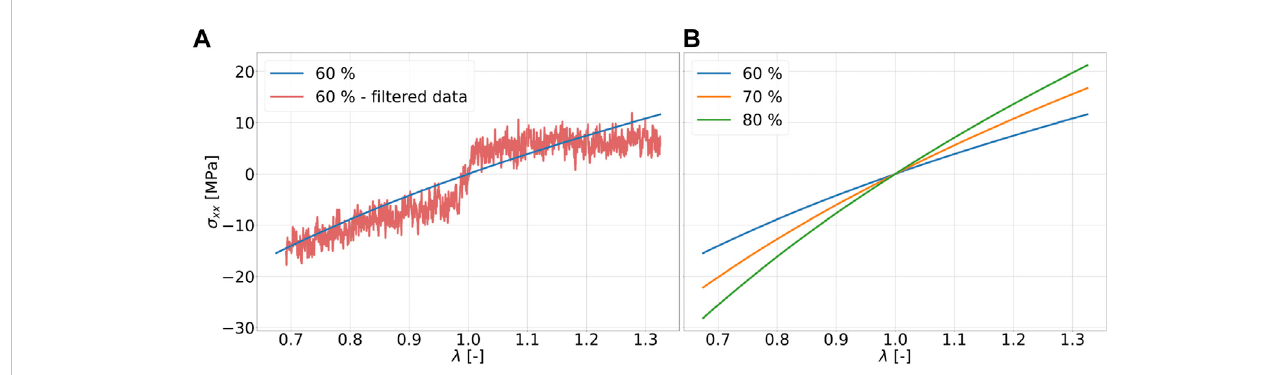
FIGURE 4 Stress-straindata of strain rate of10 7 1/s for ratio 2to 1: (A) Fit ofstress-strain data with theOgden model offor 60 percent (blue)cdc and fi ltered stress- strain data for 60 percent (red) cdc; (B) Fit of stress-strain data with the Ogden model of for 60 percent (blue), 70 percent (orange), 80 percent (green) cdc.